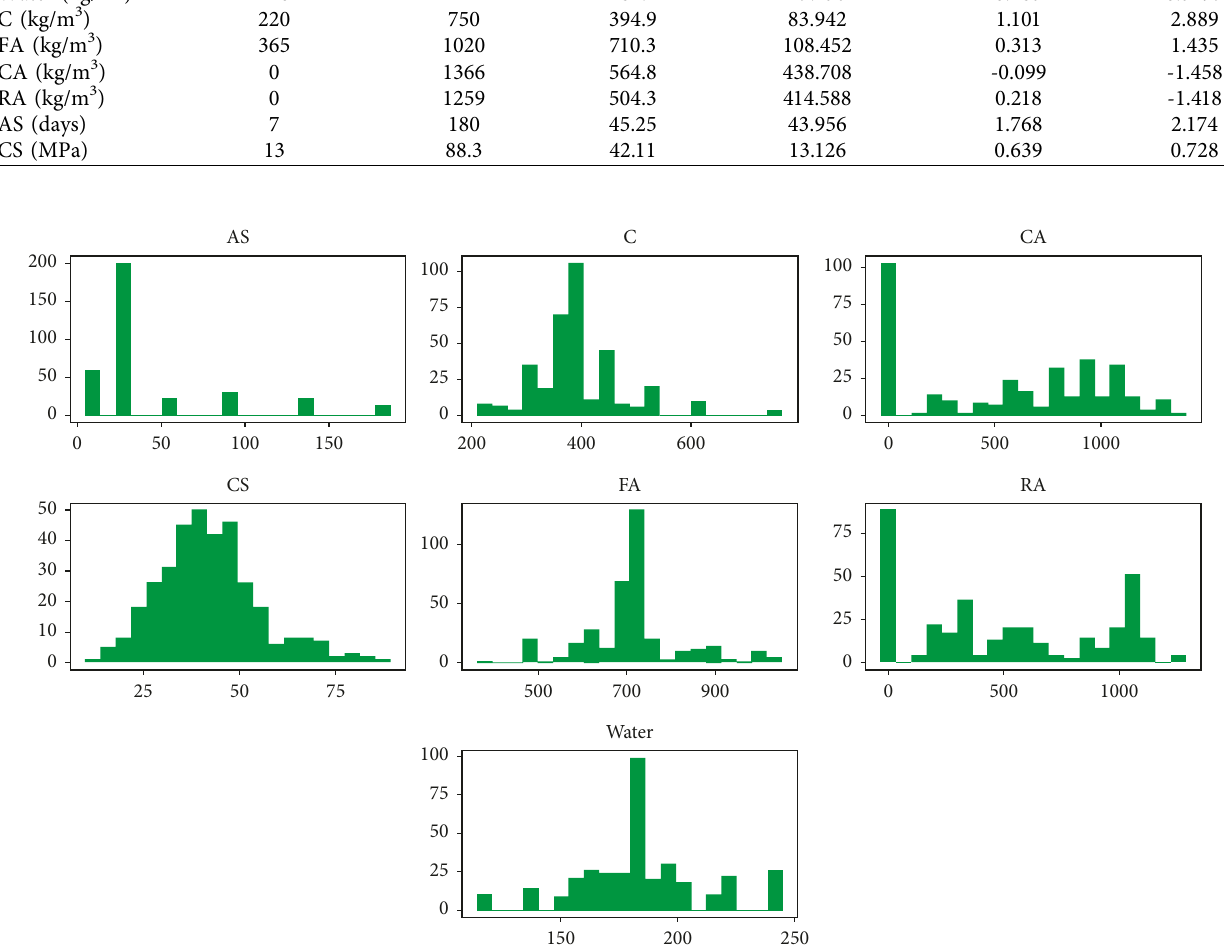
Figure 5: Histograms of the dataset used in the study.